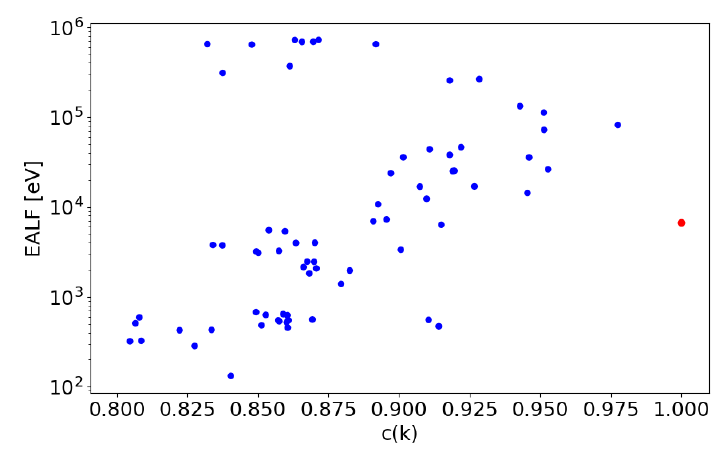
Figure 1a. EALF for the relevant experiments and Case 1.